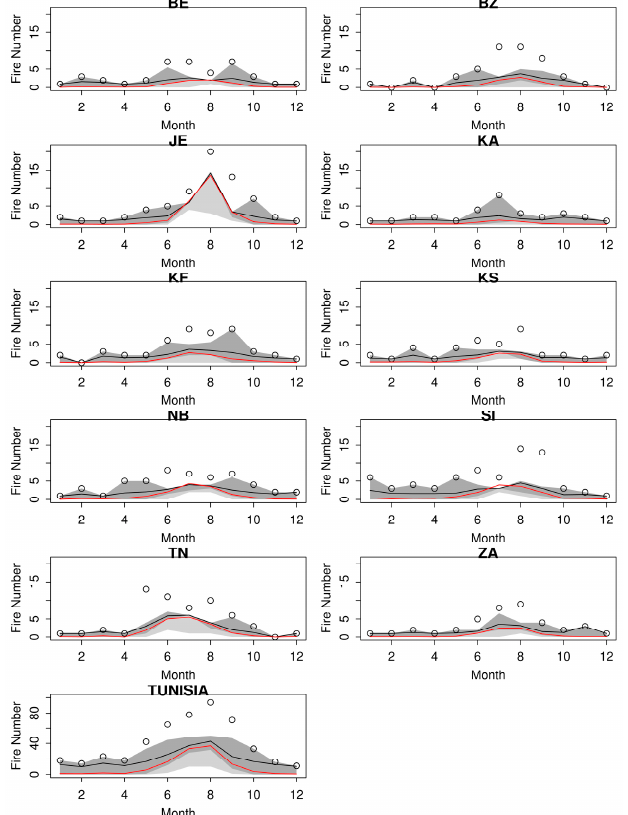
Figure 11. Seasonal (month, X -axis) pattern of fire numbers for each gouvernorat and for whole Tunisia. Each plot describes the monthly mean fire number in the COR dataset (red line), the monthly mean fire number in the COR dataset gap-filled when no fires were recorded during a given month, with the mean fire number in the time series (black line), the maximum recorded fire number during a month in the COR dataset (dots). The dark grey envelope represents the gap-filled COR dataset gap-filled with the maximum, or minimum (non-zero) fire number recorded for this month in the time series. The light grey envelope represents the minimum fire number recorded during a month in the COR dataset along the whole time series.